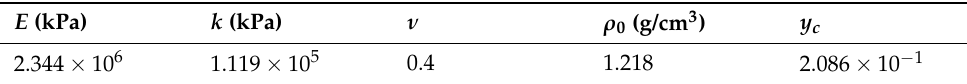
Table 3. Power law parameters for